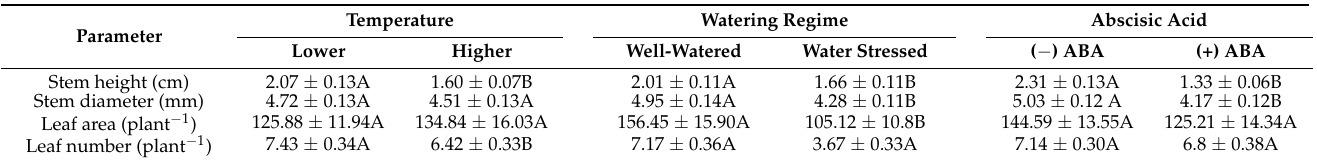
Table 2. Effects of temperature, watering regime and abscisic acid on stem height, stem diameter, leaf area, and leaf number of tomato plants.